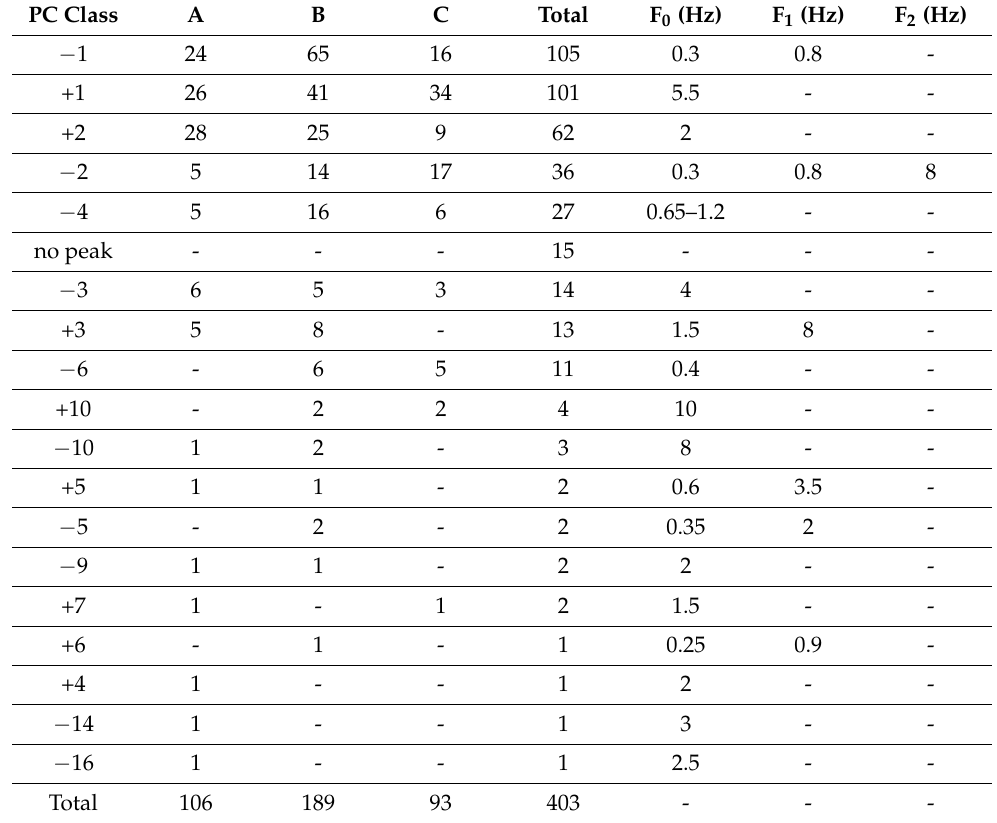
Table 3. Number of experimental HVSR curves (column Total) belonging to the classes identified by the procedure based on PCA. The term “no peak” denotes the class characterized by HVSR curves that indicate the absence of resonance phenomena. Columns A, B and C show the number of experimental curves belonging to the respective amplitude subclasses. In the last three columns, the peak frequency values identified by each group-average pattern are summarized. In particular, F 0 corresponds to the fundamental frequency value, i.e., the frequency of the lowest frequency peak; F 1 and F 2 represent the eventual higher frequency values, such that F 0 < F 1 < F 2